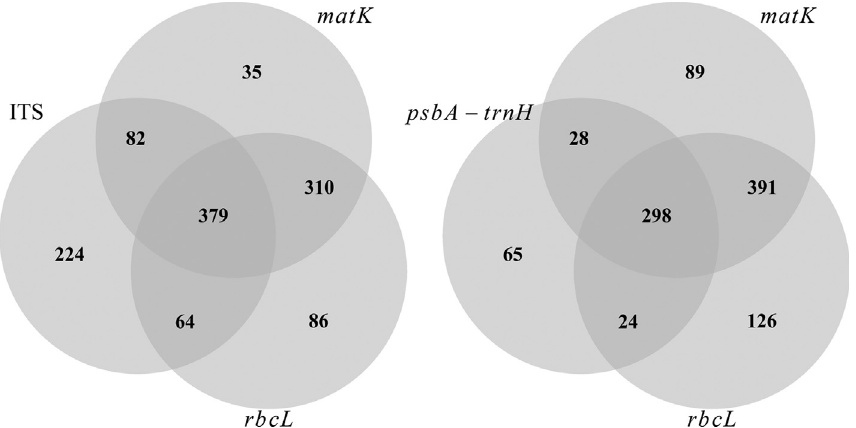
Figure 1 - Venn diagrams of the number of species with sequences for the combination of (a) rbc L + mat K + ITS region and (b) rbc L + mat K + psb A- trn